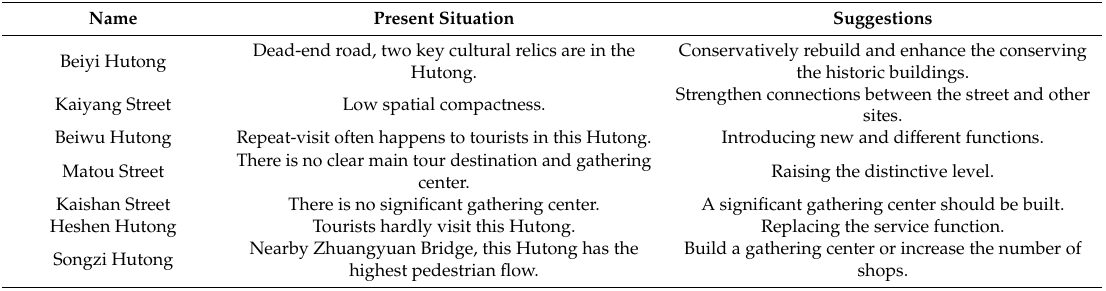
Table 6. Suggestions for improving tourists’ spatial cognition in historic districts in